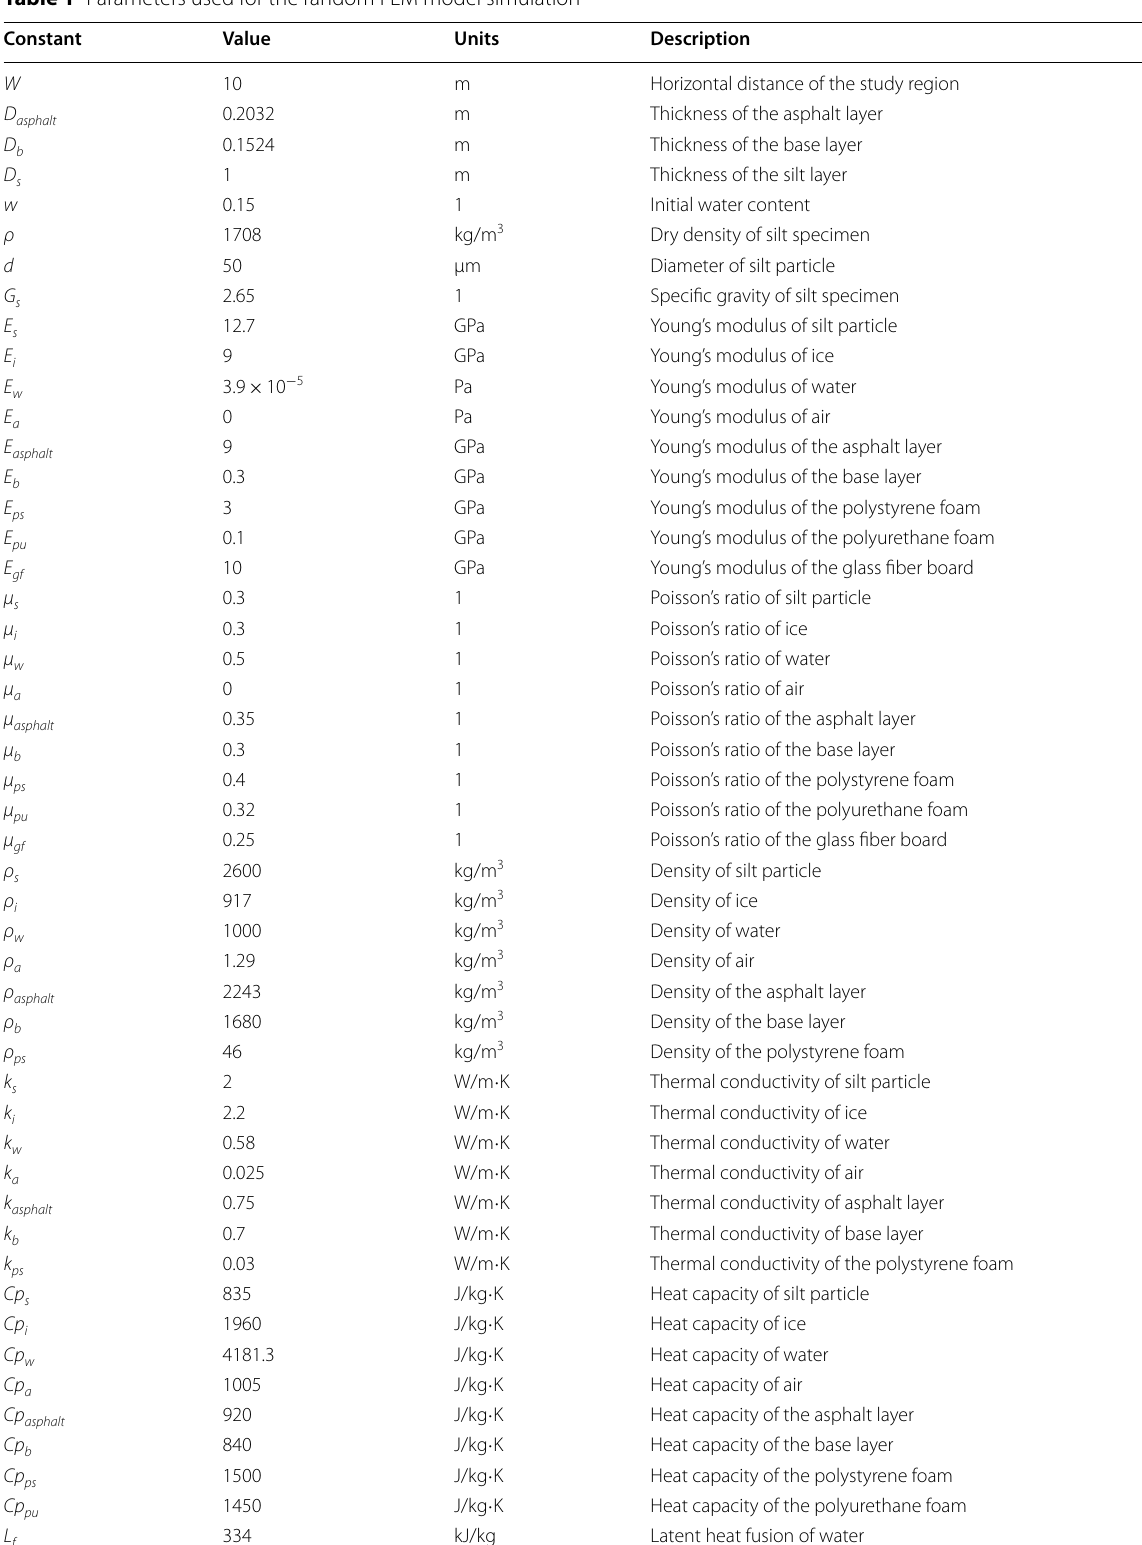
Table 1 Parameters used for the random FEM model simulation Constant Value Units